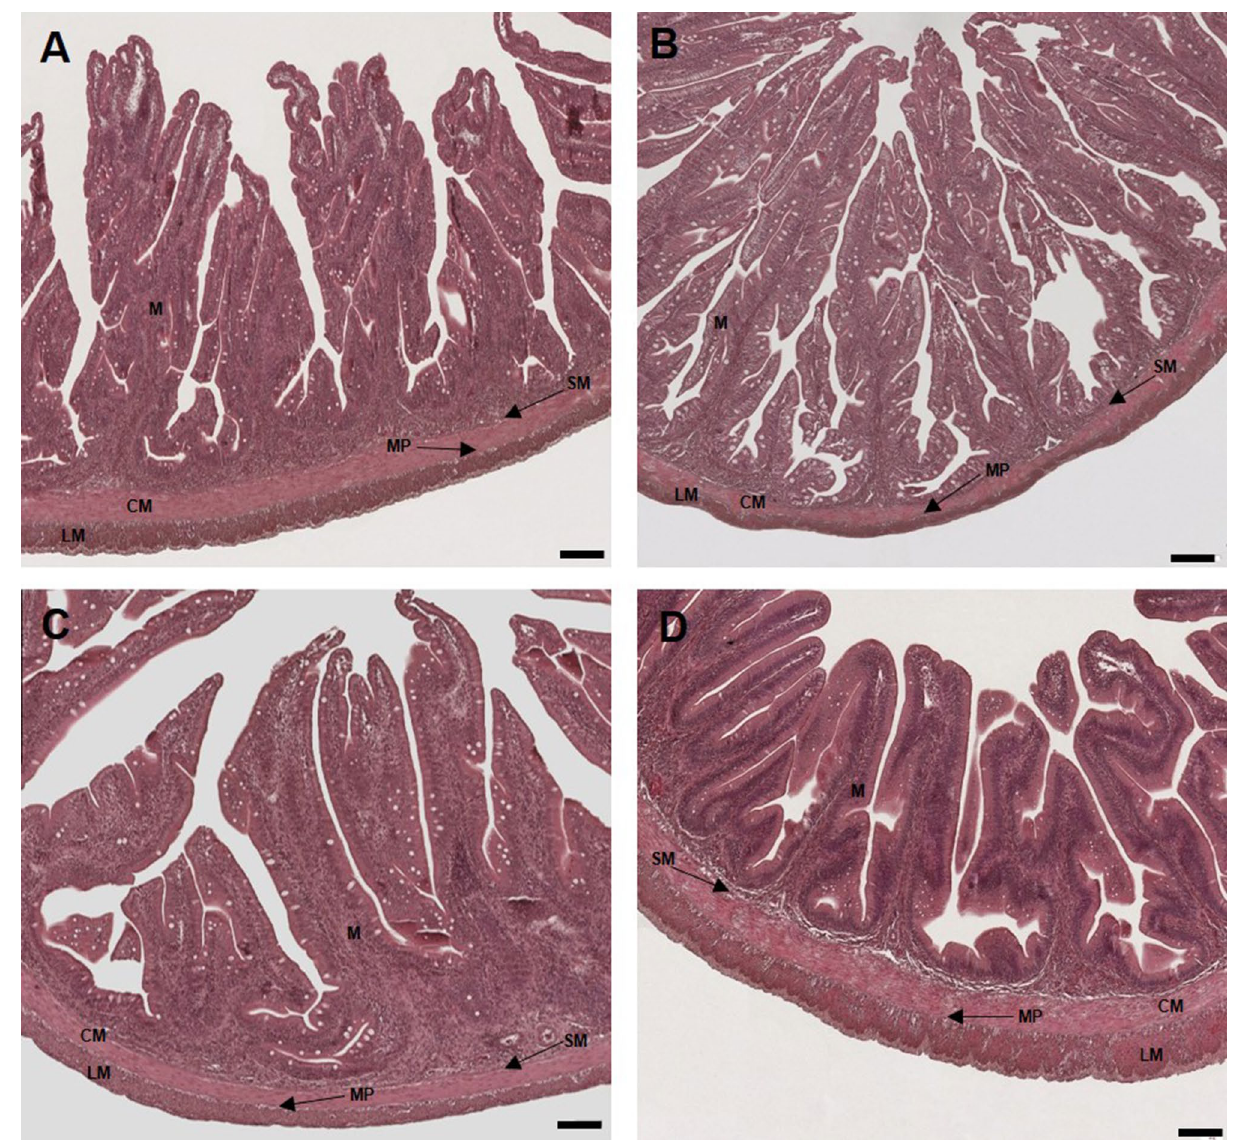
Figure 1. Standard hematoxylin–eosin (H&E) histochemical analysis of the proximal (Panels A , B ) and distal (Panels C , D ) gilthead sea bream intestine. 5 µm cross sections were obtained from proximal and distal paraffin- embedded intestine obtained from fishmeal fed fish (Panels A and C ) and Hermetia illucens meal fed animals (panels B and D ). M, mucosa; SM, submucosa; CM, circular muscle layer; LM, longitudinal muscle layer; MP, myenteric plexus. (Bar 100